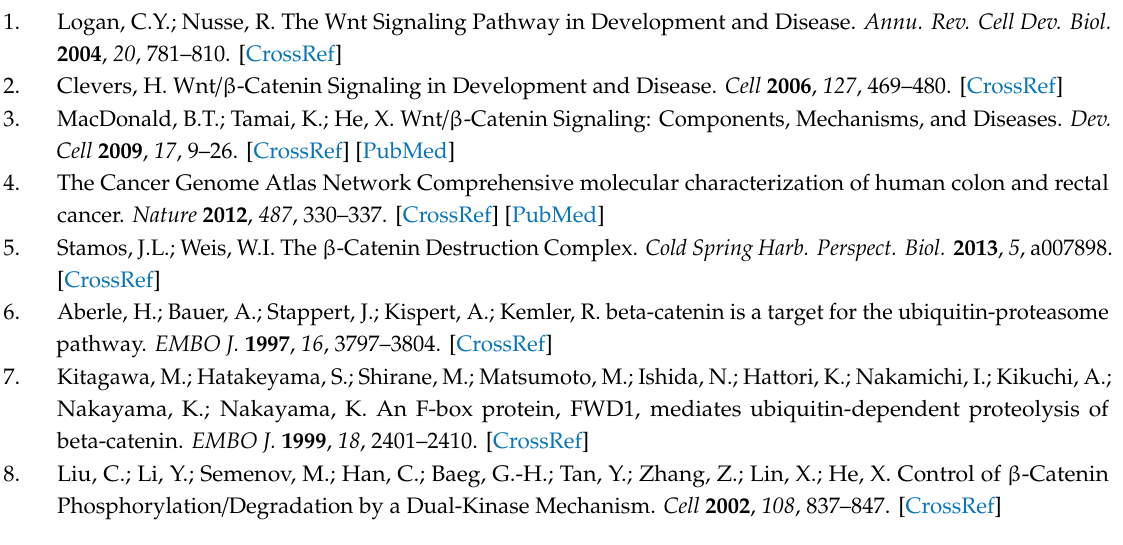
Figure S1: Validation of anti-APC-M2 chicken IgY antibody, Figure S2: Full-length Western blots, Table S1: Mutations analyzed from cBioPortal including data from: MSKCC, TCGA, DFCI, and Genentech, Table S2: Liver Cancer Patient Samples with various CTNNB1 mutations queried for Wnt target gene RNA